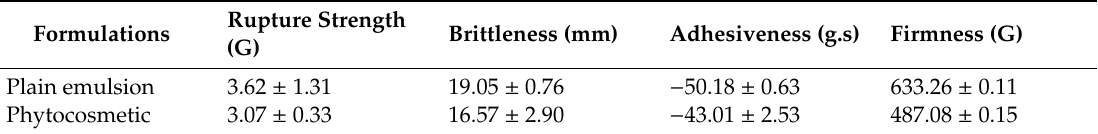
Table 2. Texture analysis of plain emulsion (without plant extract) and phytocosmetic (emulsion with the blend of plant